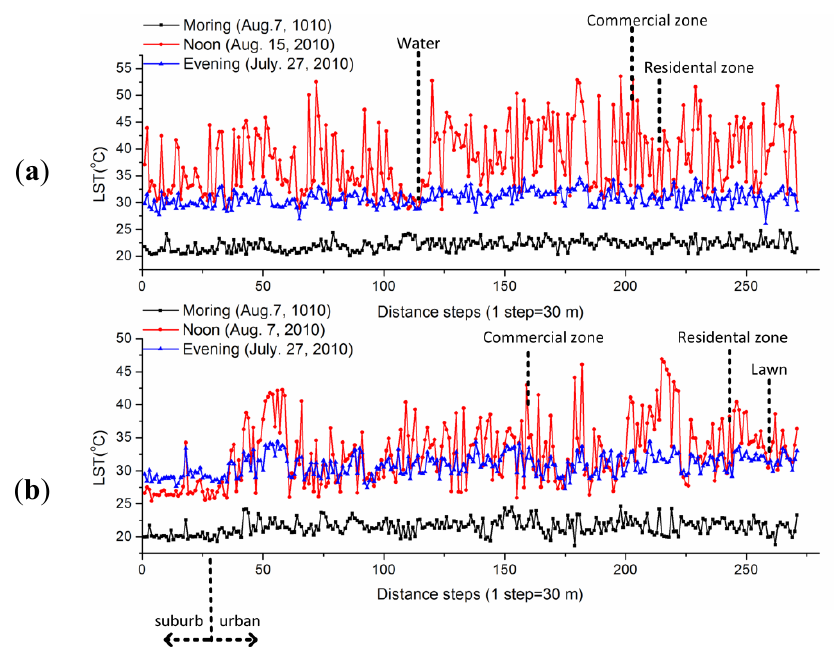
Figure 12. North–south land surface temperature profiles derived from TASI LST images, ( a ) Line 1; ( b ) Line 2 (locations marked in Figure